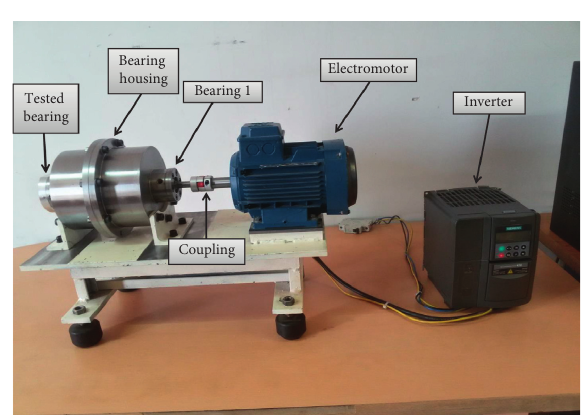
Figure 2: Experimental setup.